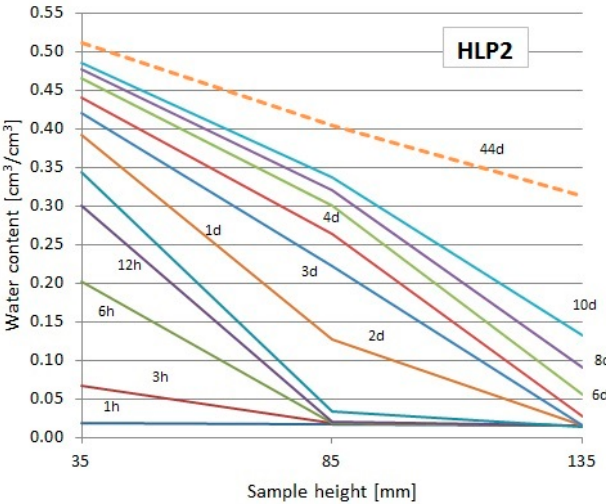
Figure 12. Moisture profiles obtained using the TDR measurement in particular intervals for the HLP2 composite.